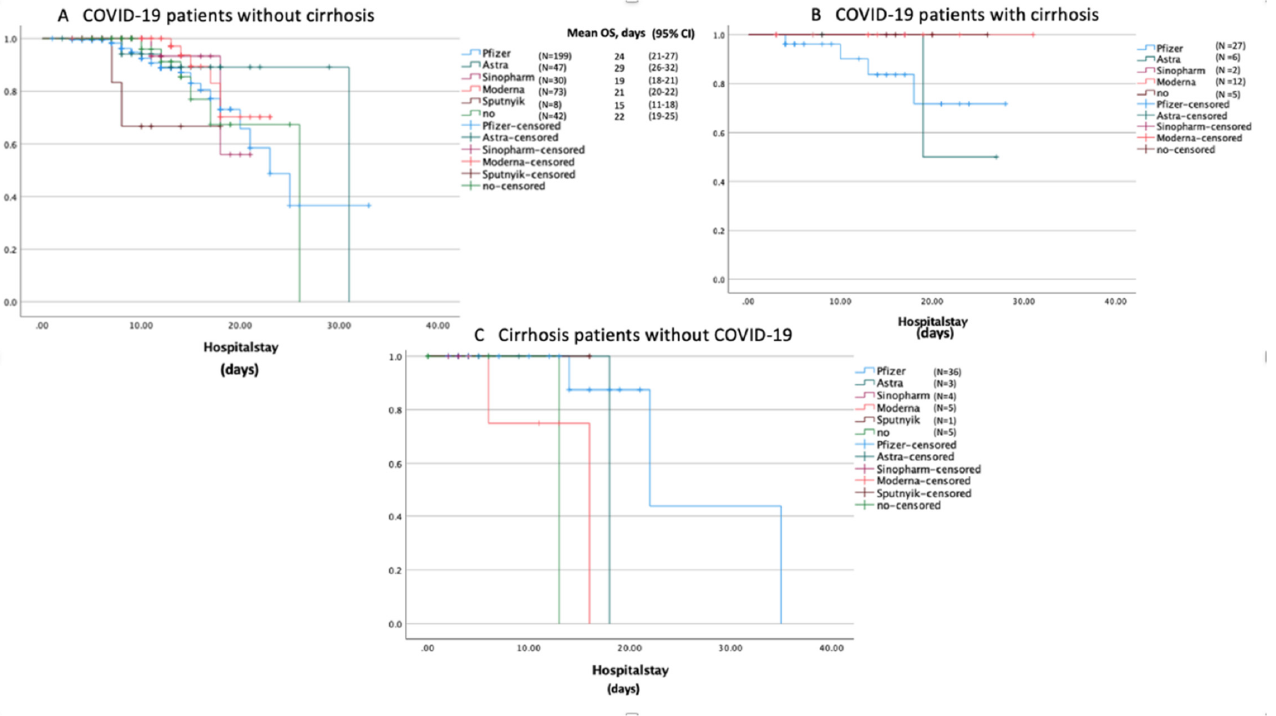
Figure 6. Kaplan–Meier survival curves displaying the estimated survival probabilities in the three groups ( A – C ) stratified by different COVID-19 vaccines. Mean overall survival (OS) and 95% confi- dence intervals (95% CI) are included, where appropriate. ( A ) In COVID-19 patients without cirrho- sis, Sputnik-V was associated with significantly lower survival rates compared to Moderna (log- rank test: p = 0.039). ( B ) In COVID-19 patients with cirrhosis, AstraZeneca was less effective to pre- vent COVID-19-related deaths in contrast to Moderna (log-rank test: p = 0.157). ( C ) Patients receiv- ing Pfizer-BioNTech had significantly better survival rates compared to those receiving Moderna (log-rank test: p = 0.017).